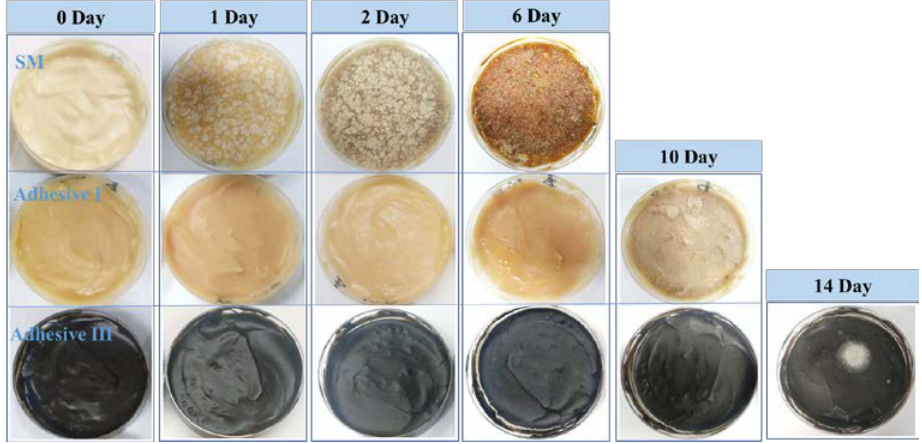
Figure 8. Mildewproof activities of the adhesives under different mildew treatment time.